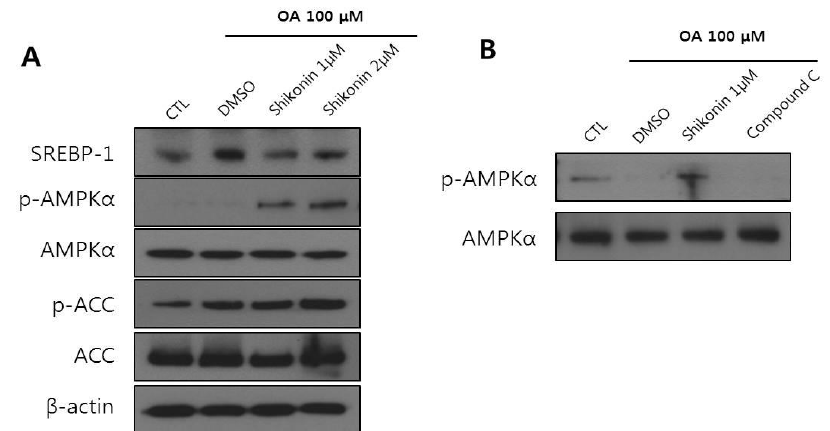
Figure 3. Shikonin increases AMPK phosphorylation and decreases sterol regulatory element binding protein-1c (SREBP-1c) in oleic acid-induced hepatic steatosis. ( A ) Hepa 1-6 cells were pretreated with 100 μM oleic acid and then incubated with shikonin for 24 h. ( B ) Cells were pretreated with 100 μM oleic acid and then incubated with either compound C (40 μM) or shikonin (2 μM) for 2 h. Protein expression was measured by Western blot analysis.